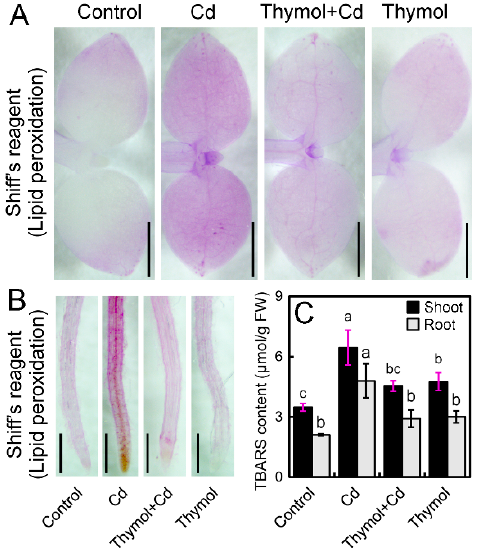
Figure 4. The effect of thymol on lipid peroxidation TBARS content in tobacco seedlings under Cd stress. The roots of seedlings were treated with water (control), CdCl 2 (20 μ M), CdCl 2 (20 μ M) + thymol (100 μ M), and thymol (100 μ M) for 72 h. ( A ) The seedlings were excised at the base of the stem and supplied Shiff’s reagent or Evans blue for 6 h through the cut stems. Then the leaves were decolorized with ethanol and photographed with a stereoscopic microscope. Bar = 1 mm; ( B ) The roots were stained directly with Shiff’s reagent and photographed with a stereoscopic microscope. Bar = 1 mm; ( C ) Shoots and roots were harvested, respectively, for the measurement of TBARS content. Different letters indicated that the mean values of three replicates are significantly different between the treatments ( p < 0.05, ANOVA, LSD).